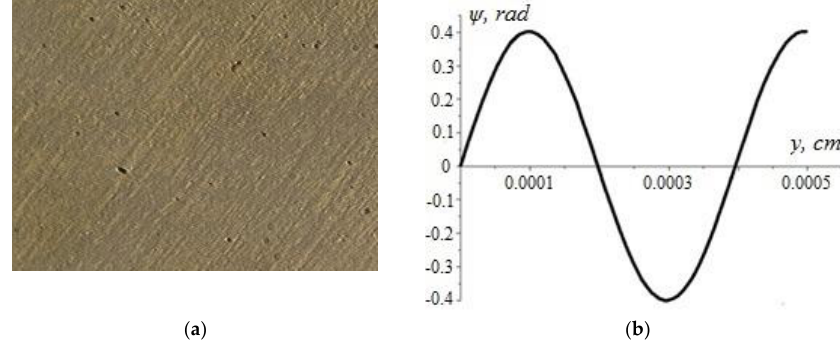
Figure 2. Alternation of light and dark bands, illustrating the spatially periodic deformation of smectic layers: ( a ) observed experimentally and ( b ) calculated (see Section 5).